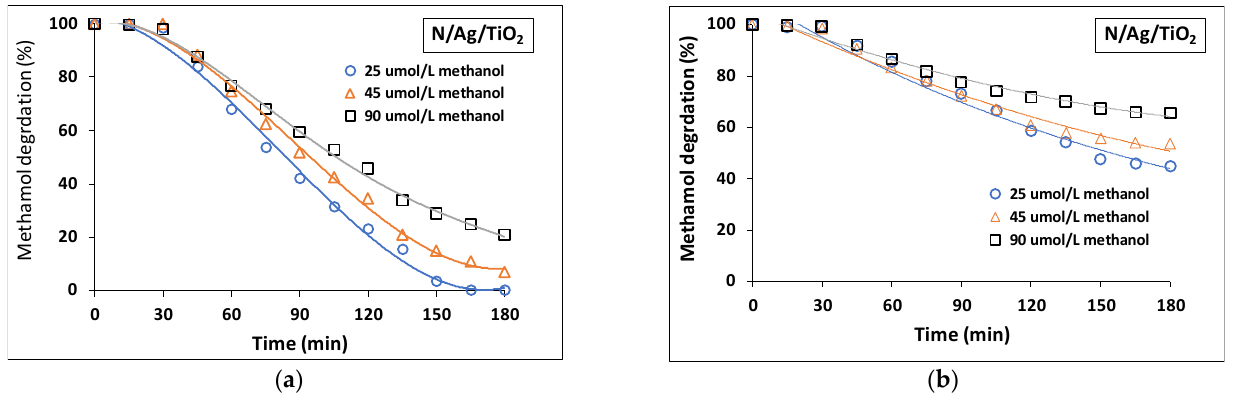
Figure 10. Photocatalytic performance of methanol degradation at three different initial concentrations of methanol (25, 45 and 90 µmol/L) with 2 wt.% N/Ag/TiO 2 coated on a mesh under ( a ) near-UV light and ( b ) visible light. Note: Reported data are for at least three repeats with 10 ± 2% SD.